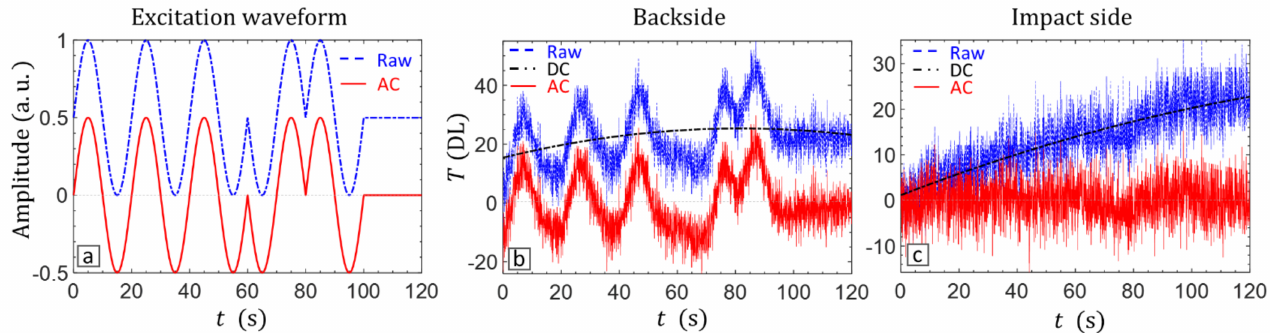
Figure 4. ( a ) A 5 bit Barker coded waveform extended with one bit of step heating. Raw thermal response and extracted alternating (AC) and direct (DC) components at a random pixel in the defected area: ( b ) backside and ( c ) impact